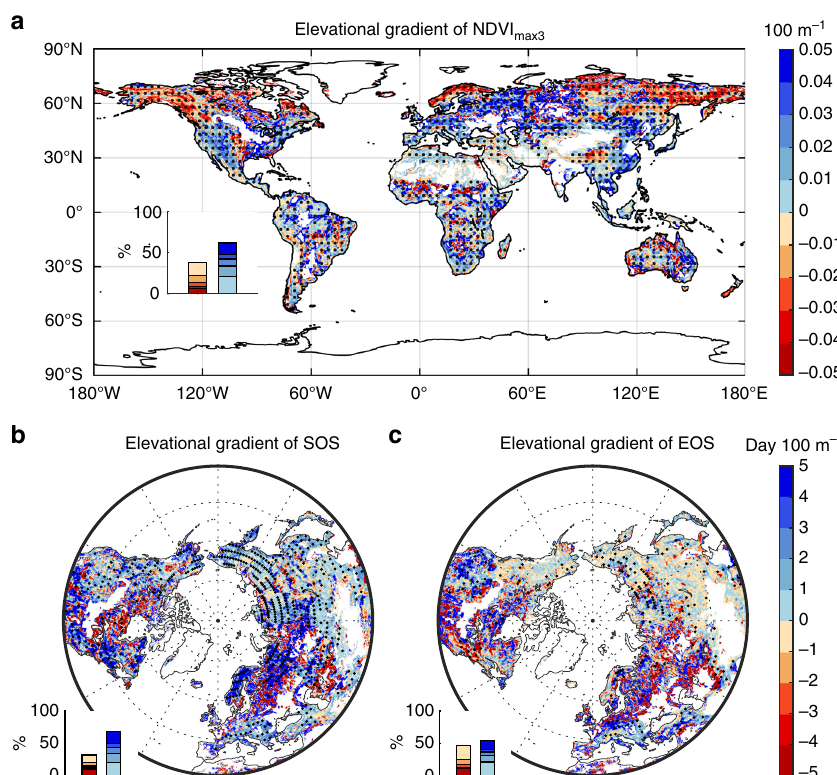
Fig. 1 The elevational gradient (EG) of vegetation activity indices. a The spatial pattern of the EG of NDVI max3 (EG ndvimax ) from 1982 to 2015. b the spatial pattern of the EG of SOS (EG SOS ) from 1982 – 2011 over the Northern Hemisphere (north of 30°N). c The spatial pattern of the EG of EOS (EG EOS ) from 1982 to 2011 over the Northern Hemisphere. A frequency distribution of the EG values is shown in the inset at the bottom-left for each panel. Regions marked with dots have statistically signi fi cant ( p < 0.05 with the F -test) EG